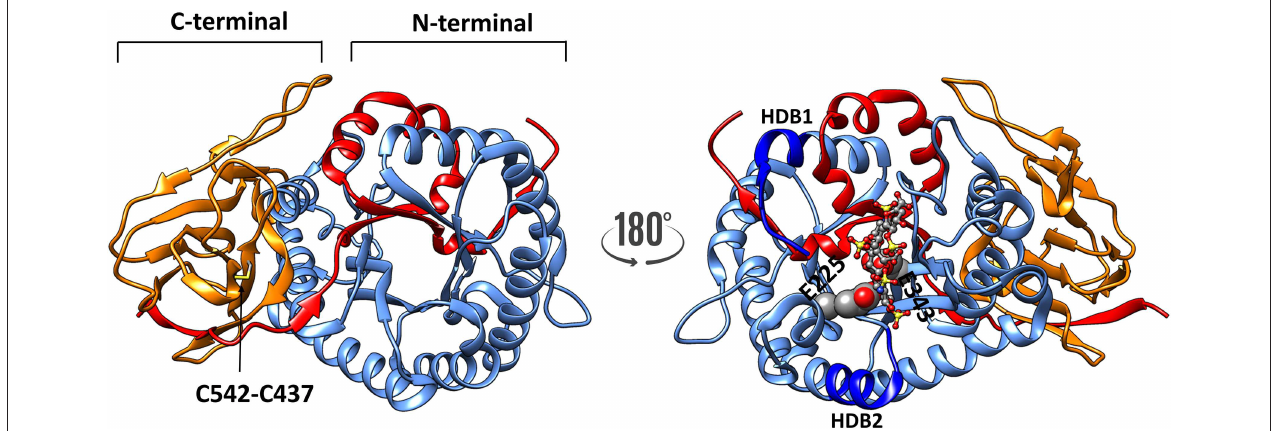
FIGURE 1 | The three-dimensional structure of heparanase (PDB code: 5e9c) showing the 8 kDa unit as red ribbon, whereas the catalytic (TIM barrel) is shown in blue. The C-terminal 413–543 shown in orange ribbon. There is a disulphide bond C437-542 (indicated by an arrow) present in both activated heparanase and proheparanase. The disulphide bond and heparin tetrasaccharide are shown in sticks representation, whereas the catalytic residues are shown as spheres, respectively. HBD1 and HBD2 (dark blue) refer to heparin binding sites consisting of residues 158–171 and 270–280,